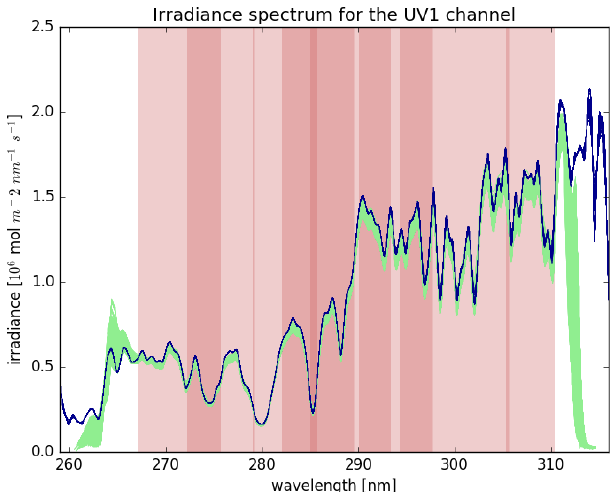
Figure 13. Measured UV1 irradiance spectrum in orbit 1157 plotted in green for all rows versus the collection-3 nominal wavelength map. The high-resolution solar reference spectrum is depicted in blue. The spectral fit windows are shown as red vertical bands, with some overlap causing the darker red